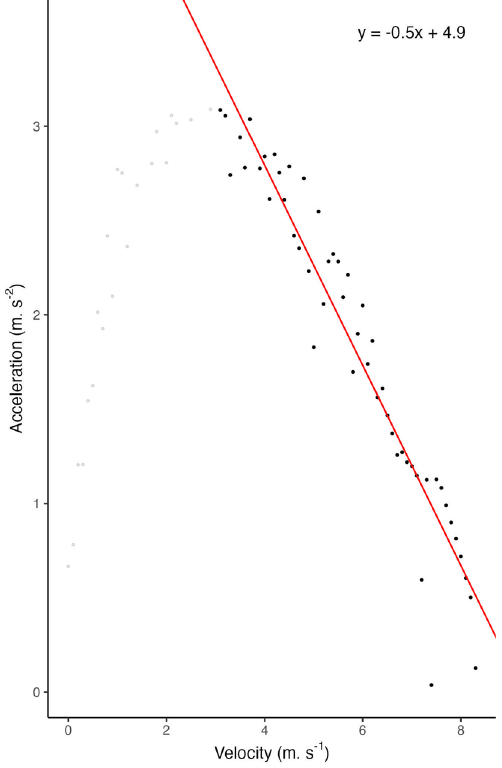
Figure 1. Example of A-V profile modeled for a given player and a randomly selected game. Only plain dots (velocities above 3 m s −1 ) were used for fitting the linear